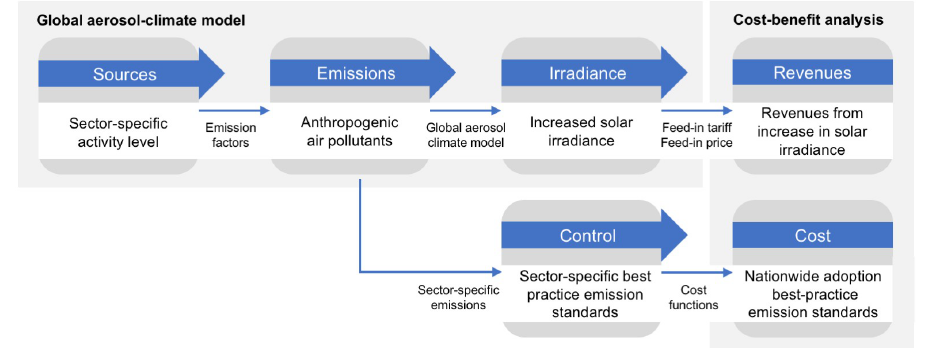
Fig 1. Framework for evaluating the cost of clean-air policies and the revenues to the solar